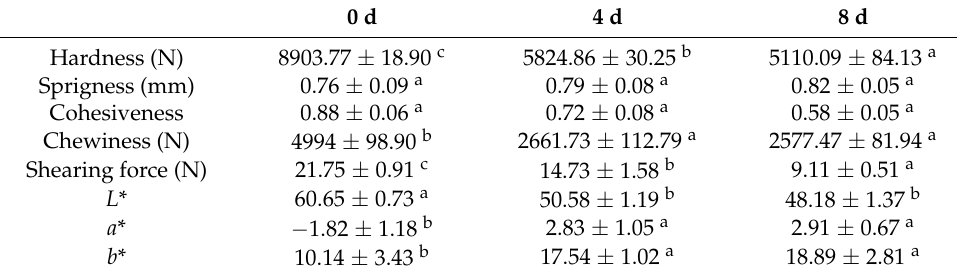
Table 1. Changes of texture and color parameters during the process of fermented vinasse hairtails. 0 d 4